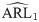

ARL^1 curves evaluation for the inflated beta regression control chart (solid line), regression control chart (dashed line), and inflated beta control chart (dotted line) when the mean is out-of-control.